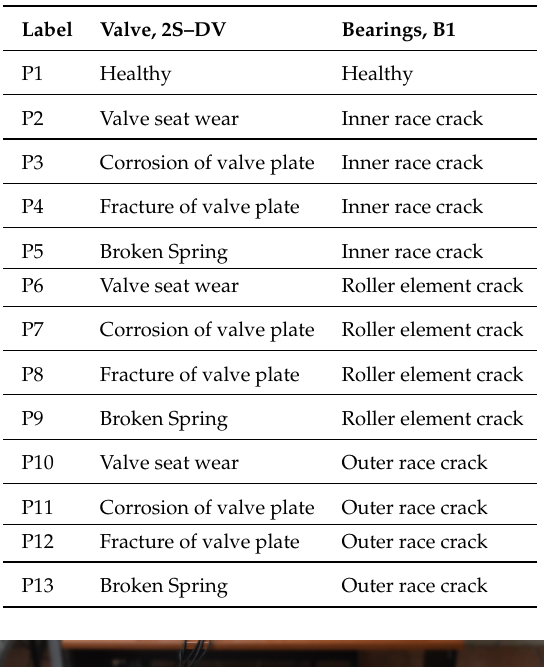
Table 1. Multi-faults in valve and roller bearings.